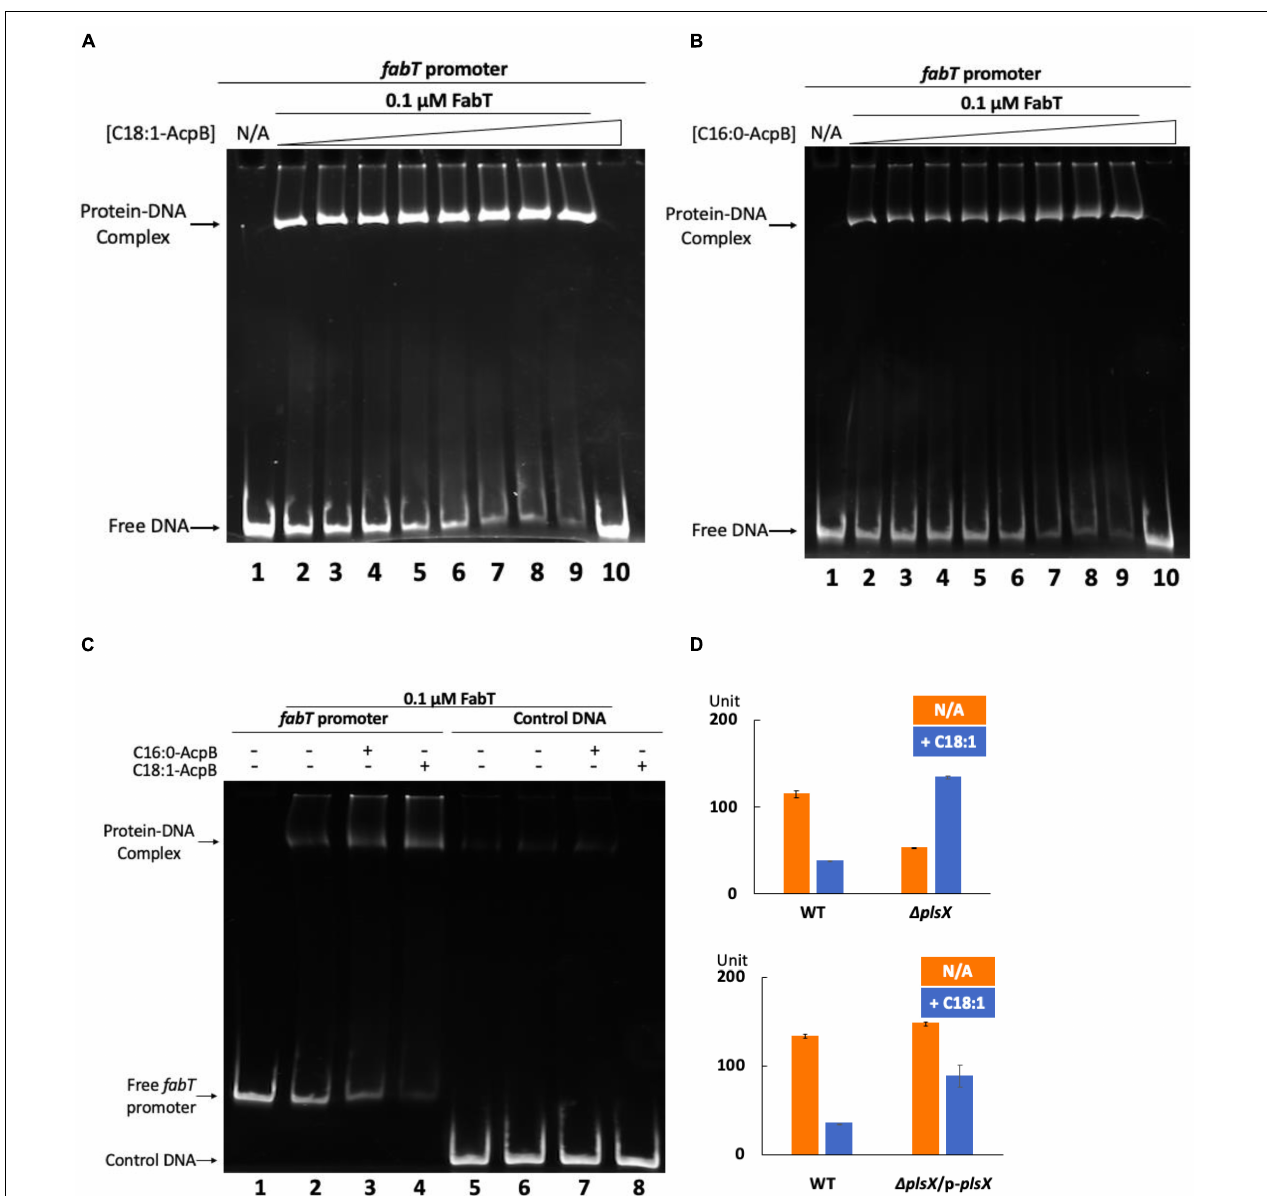
FIGURE 6 | Enterococcus faecalis acyl-AcpB enhances FabT transcriptional repression. (A) EMSA analysis of E. faecalis FabT binding to the fabT promoter in the presence of increasing concentrations of oleoyl-AcpB. (B) EMSA analysis of E. faecalis FabT binding to fabT promoter in the presence of increasing concentrations of palmitoyl-AcpB. (C) EMSA analysis of E. faecalis FabT binding to the fabT promoter or to a control unrelated DNA fragment. (D) The effects of oleic acid supplementation on expression of β -galactosidase from the fabT promoter in E. faecalis (cid:49) plsX (top panel) and (cid:49) plsX -complemented (lower panel)